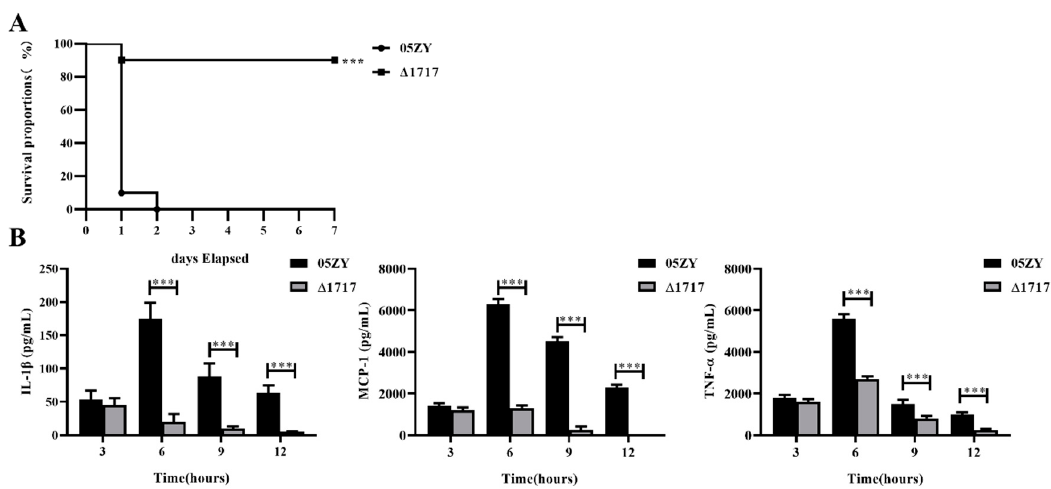
Figure 8. Mice infection and blood cytokine detection in an in vivo experiment. ( A ) Mice infection experiment. Female C57BL / 6 mice in di ff erent groups were intraperitoneally infected with 6 × 10 8 CFU of 05ZY or an equal quantity of ∆ 1717. The mortality of mice was recorded for 1 week. The results shown are representative of three independent experiments. ( B ) Blood cytokine detection in vivo experiment. Forty 4-week-old female C57BL / 6 mice were randomly assigned to one of two groups (20 mice / group). One group was challenged with a non-lethal dose (2 × 10 8 CFU per mouse) of 05ZY, and the other group was given an equal quantity of the ∆ 1717 strain. At 3, 6, 9, and 12 h post-infection, five mice in each group were sacrificed to collect blood for ELISA detection of IL-1 β , MCP-1, and TNF- α production. *** p < 0.001.